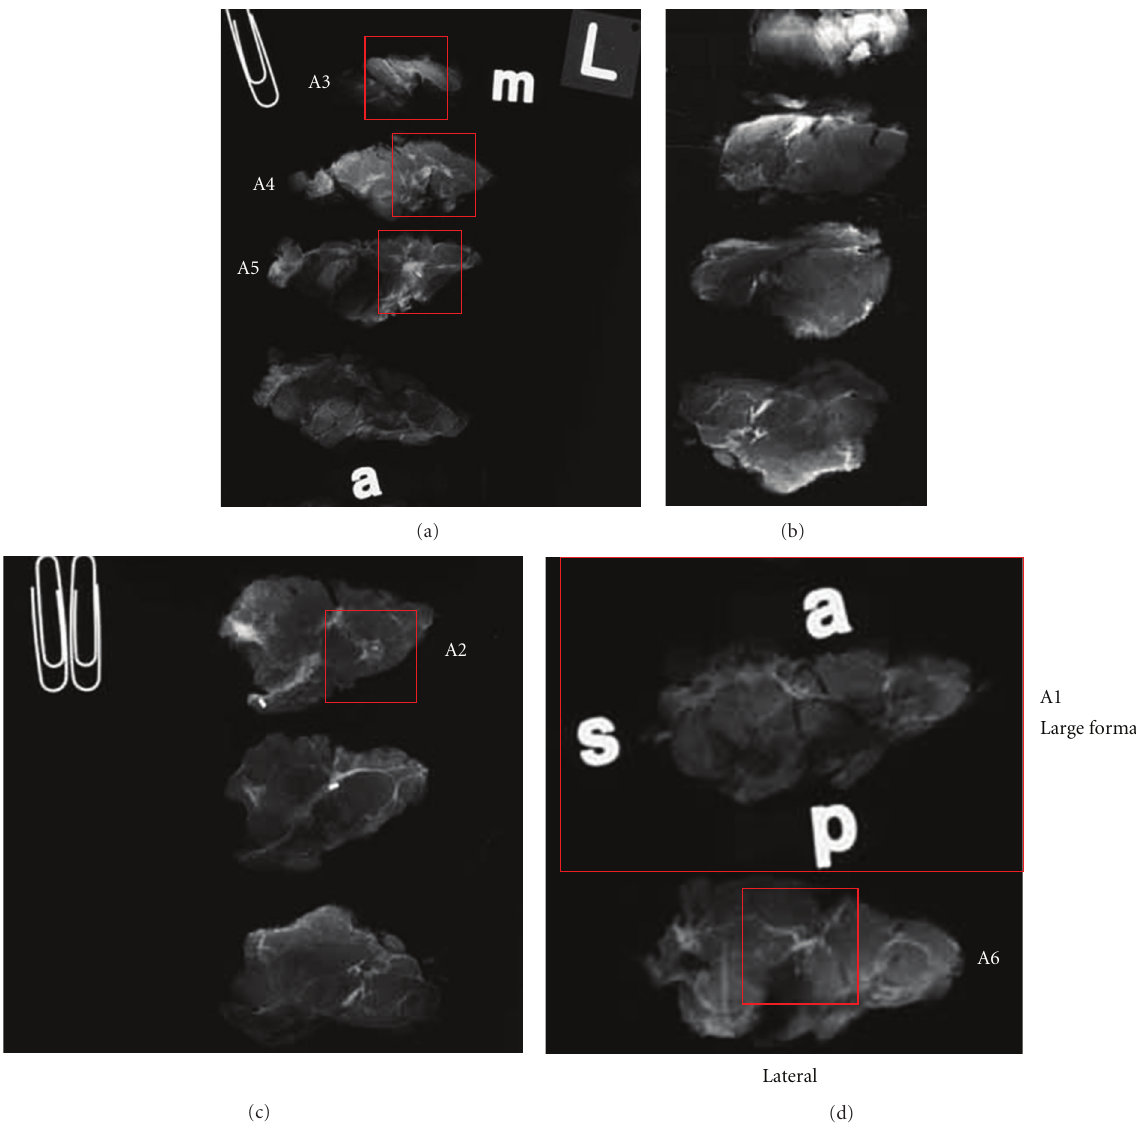
Figure 2: Specimen radiographs from lumpectomy shown in Figure 1 marked after pathologic examination. Red rectangles denote tissue blocks removed for microscopic examination. Block A1 consists of a large-format tissue section with circumferential surgical margins in the sagittal plane. Orientation is maintained on the radiograph with opaque letters “a” (anterior), “s” (superior), and “p” (posterior). The inferior margin is opposite superior (unmarked). Blocks A2–A6 are conventionally sized. Medial and lateral surgical margins are represented by conventional sections A3 and A6, respectively. Blocks A2 and A4 were removed to address specific findings identified by the breast